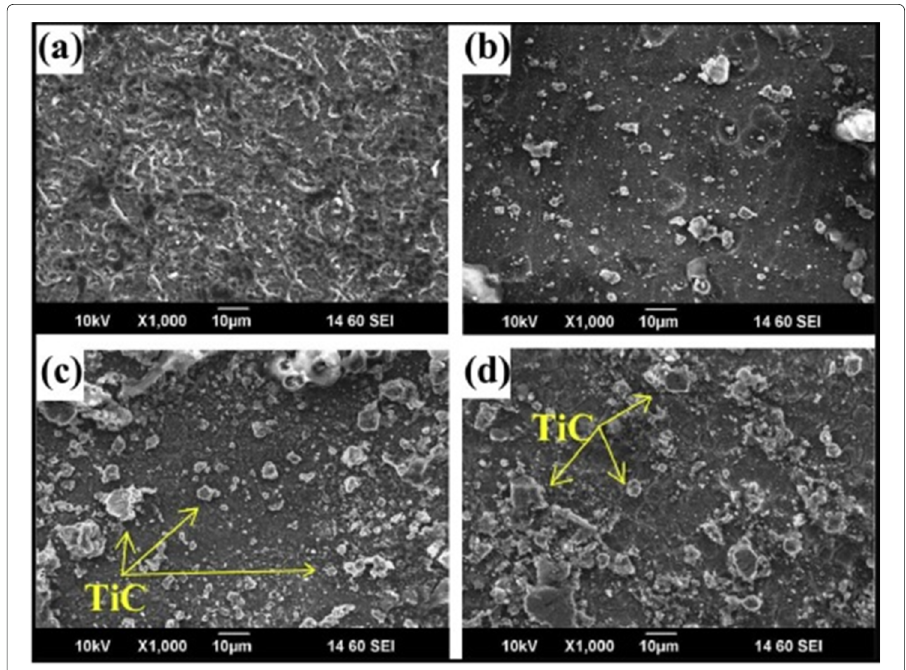
Fig. 10 SEM images of AZ31/TiC composite containing a 0 vol.% TiC, b 6 vol.% TiC, c 12 vol.% TiC, and d 18 vol.% TiC